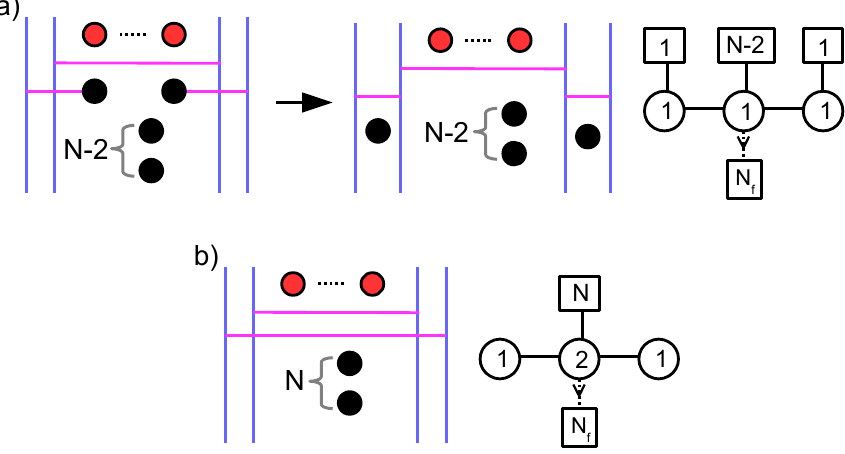
Figure 11 . This (cid:12)gures illustrates the brane con(cid:12)gurations and their associated SMMs for the chamber dependent terms that arise in the correlator